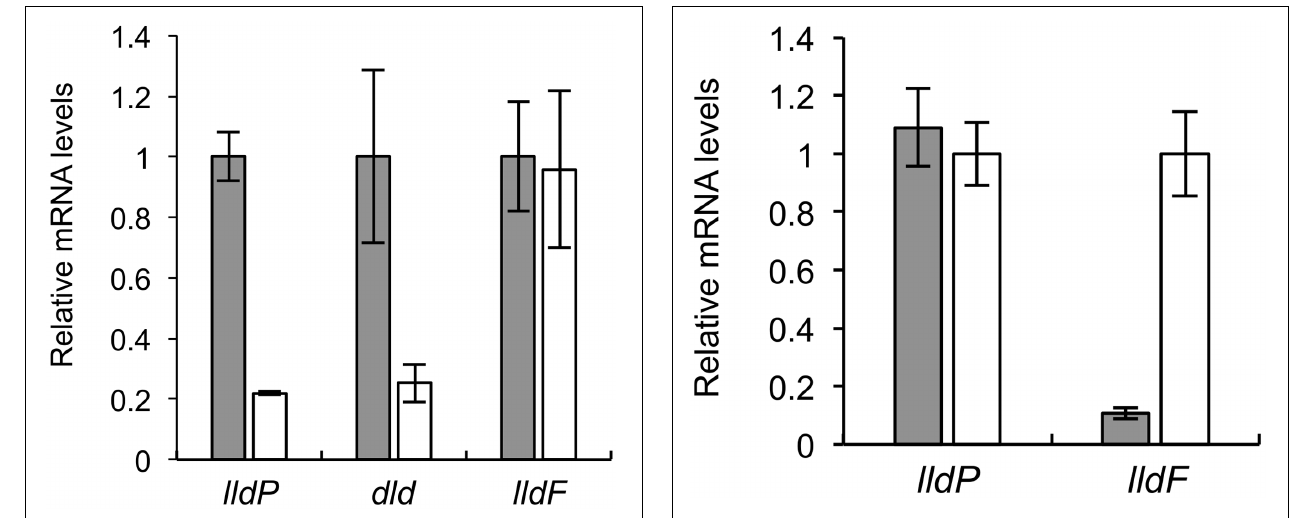
FIGURE 6 | Quantitative RT-PCR analyses of lldP and lldF in WT grown on D -lactate (gray bars) or L -lactate (white bars). Cells were grown in MM containing 10 mM D - or L -lactate and harvested in the logarithmic growth phase. Data are expressed as relative values to mRNA levels in cells grown on L -lactate. Error bars represent standard deviations calculated from at least three independent